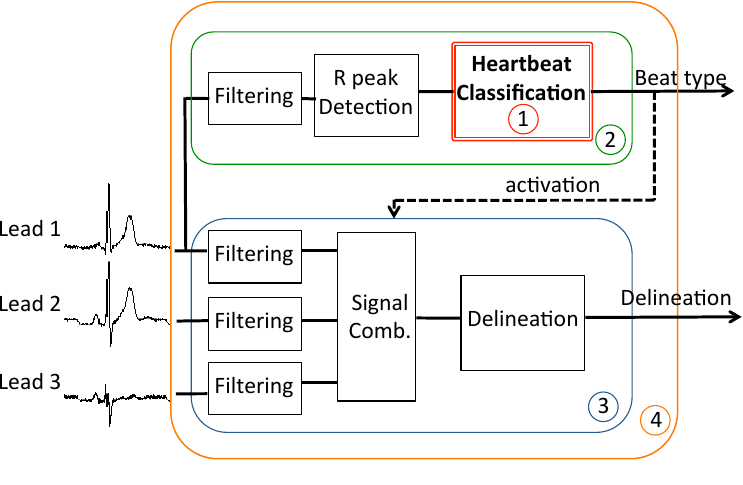
Figure 6. Experimental scenario: classification is used to activate an accurate multi-lead morphological delineation only in case of heartbeat abnormality.